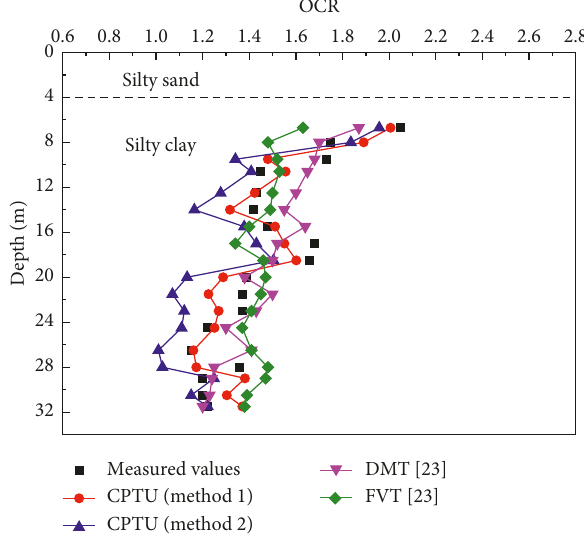
Figure 12: The predicted values of OCR based on CPTU, DMT, and FVT for D2 test site in Busan, South